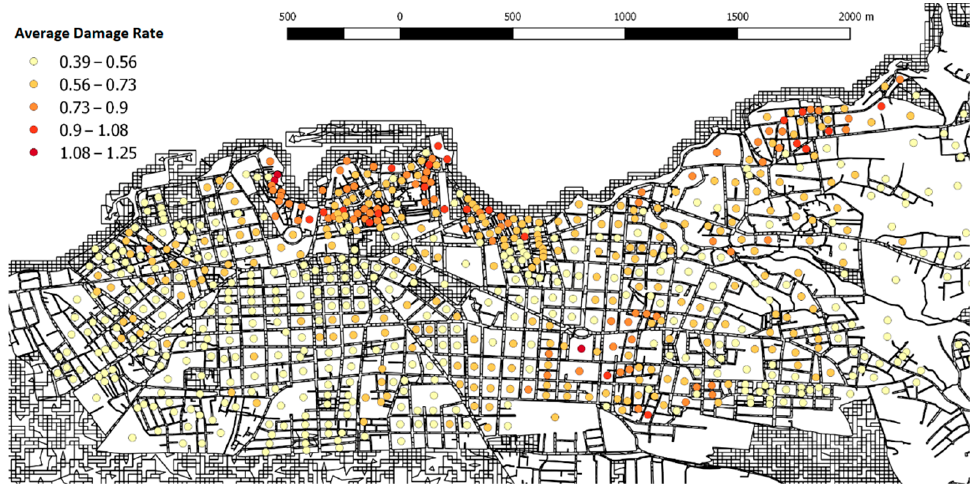
Figure 8. Estimated average damage per building block according to the average values of the available QuakeIST library average attenuation relationship (generic law).